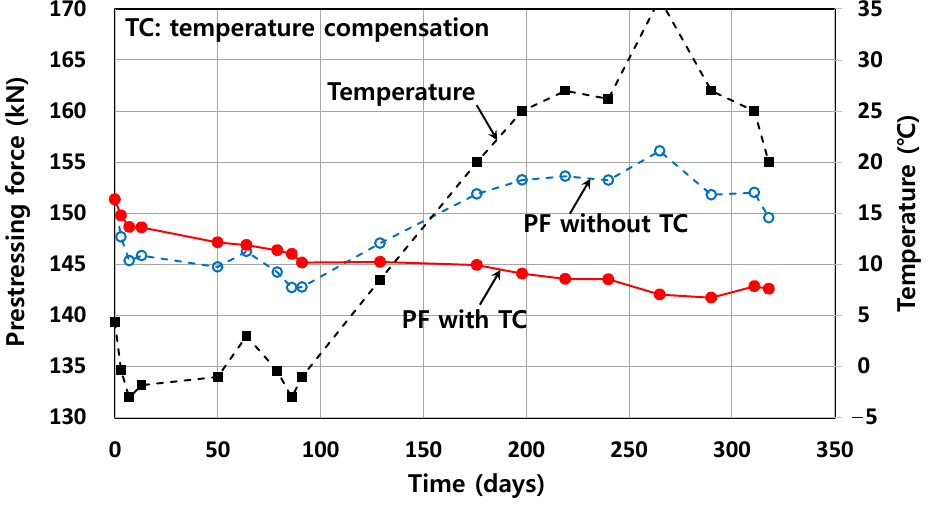
Figure 10. Effect of TC on PF.